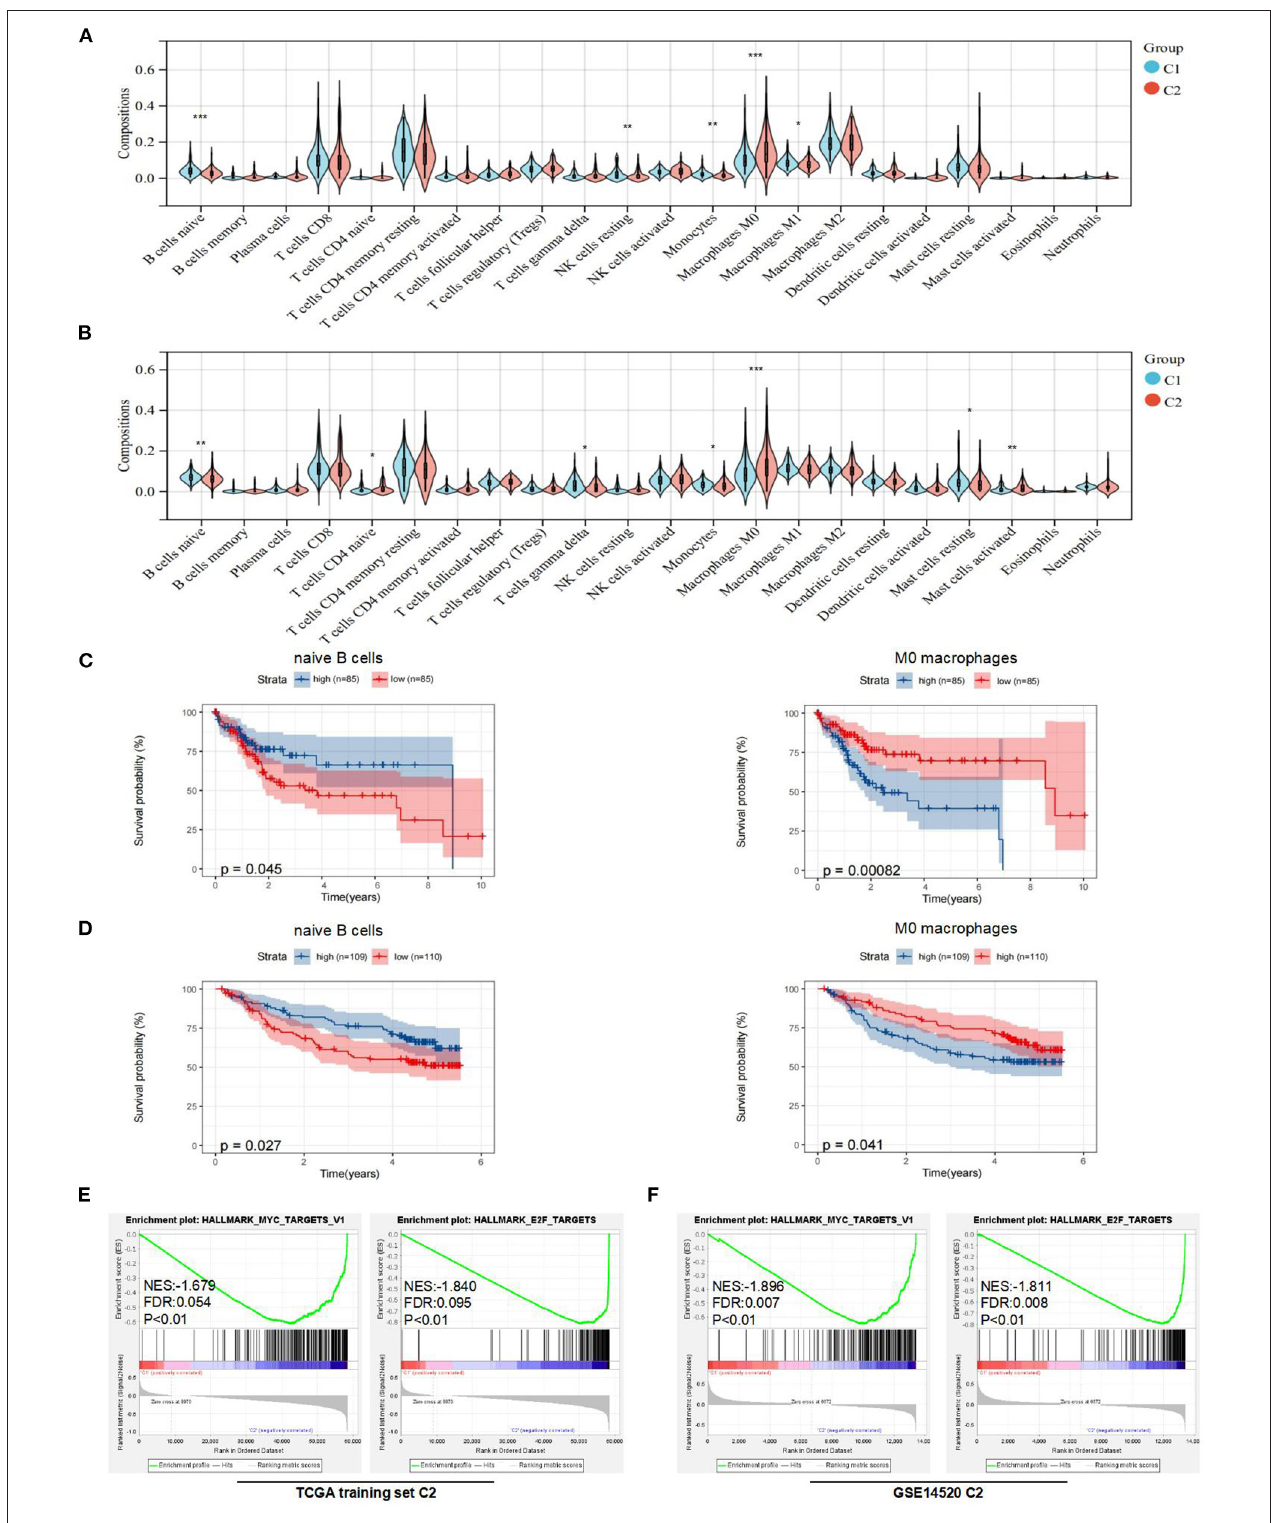
FIGURE 3 | Analysis of immune features and gene set enrichment analysis (GSEA) between subtypes. (A) Comparison of immune cells in the tumor microenvironment (TME) between C1 and C2 in the TCGA training set. (B) Comparison of immune cells in the TME between C1 and C2 in the Gene Expression Omnibus (GEO) dataset. (C) KM curve analysis of overall survival between high and low compositions of immune cells (naive B cells and M0 macrophages) in the TCGA training set. (D) KM curve analysis of overall survival between high and low compositions of immune cells (naive B cells and M0 macrophages) in the GSE14520. (E) GSEA analysis in the TCGA training set. (F) GSEA analysis in the GSE14520. * p < 0.05, ** p < 0.01, and *** p < 0.001.